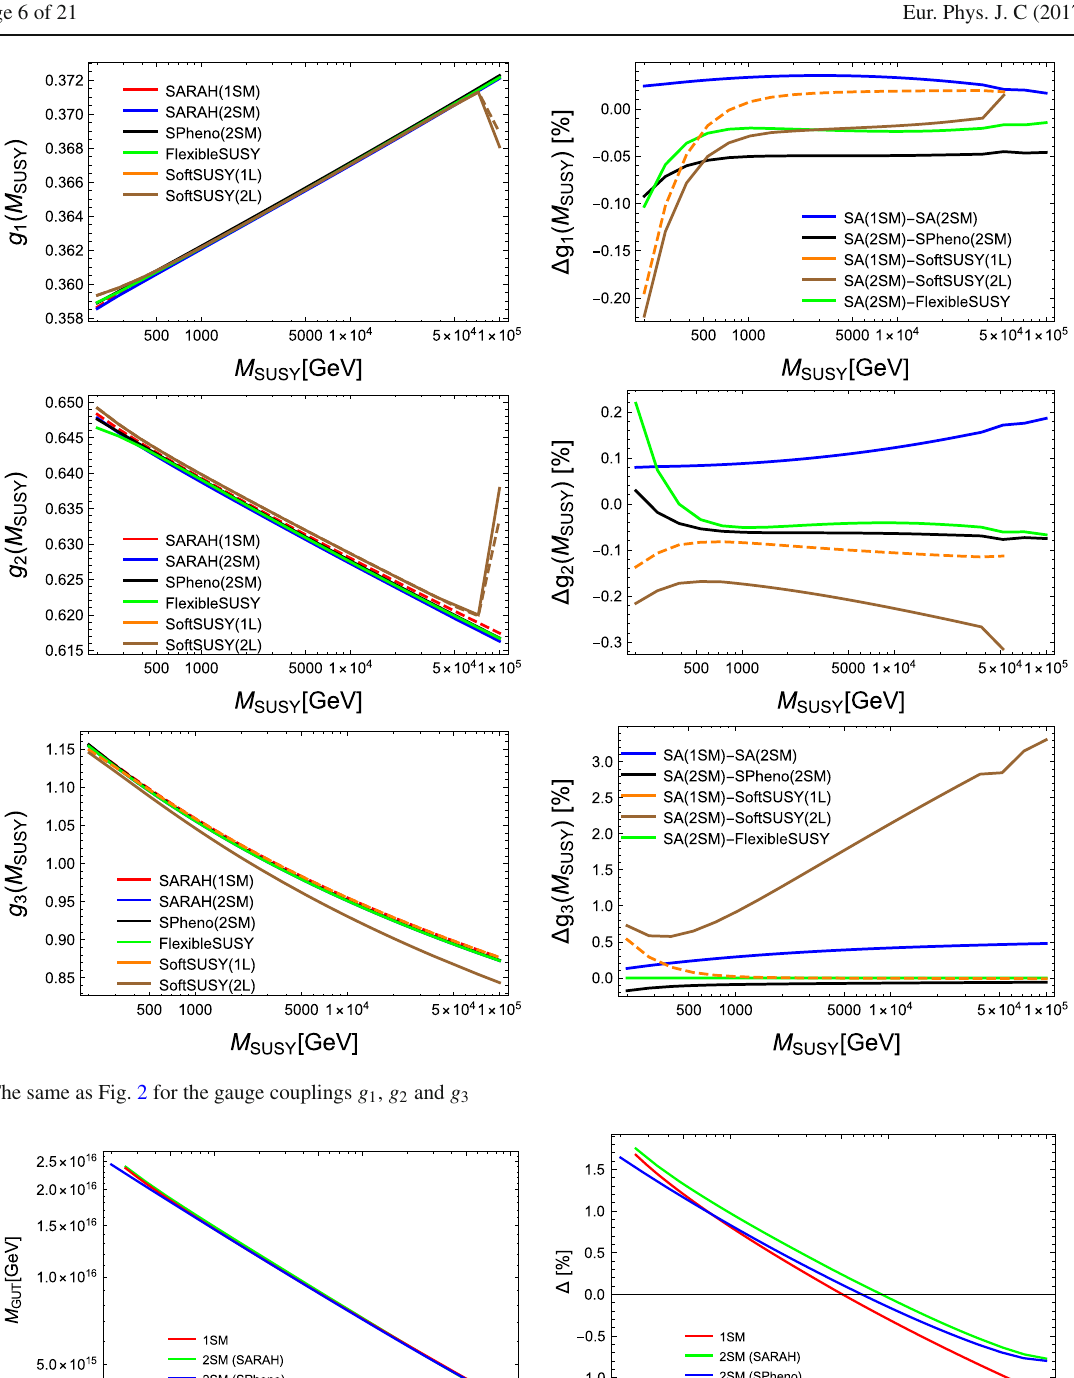
Fig. 4 On the left : the predicted value for M GUT as a function of m 0 = M 1 / 2 in the CMSSM. The red line corresponds to the old one- scale matching, while the blue and green line are the results for the two-scale matching with SARAH and SPheno . On the right : the dif-